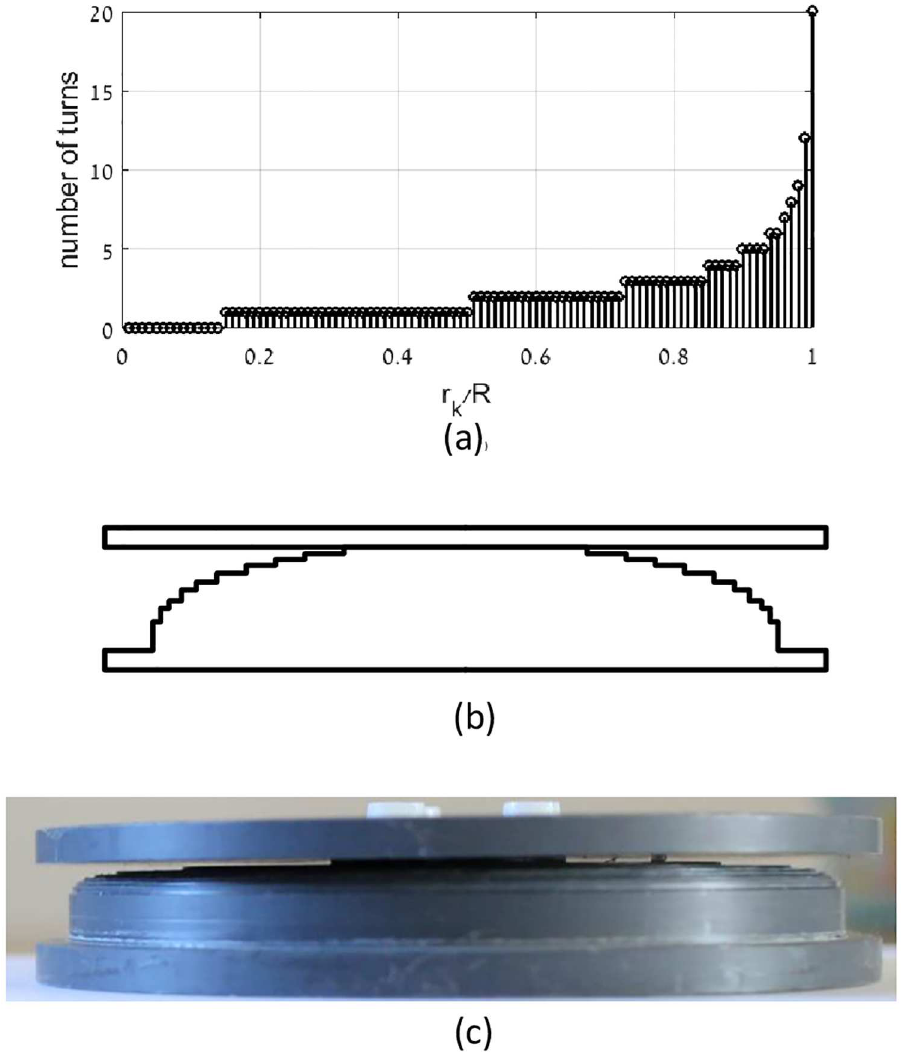
Fig 16. (a) Current distribution at the stepped coil, (b) the cross section sketch of the stepped coil bobbin (not to scale), and (c) the bobbin that implements the stepped current